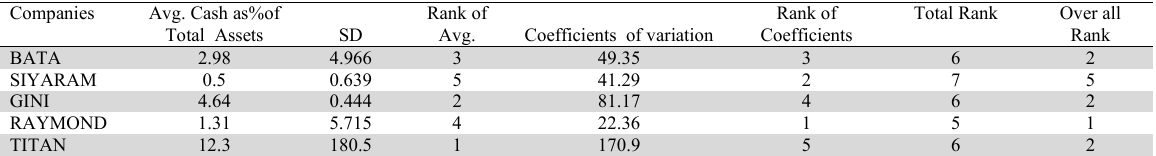
Ranking on the basis of Average and Consistency of Average Cash Holding of the Selected Companies of Retail